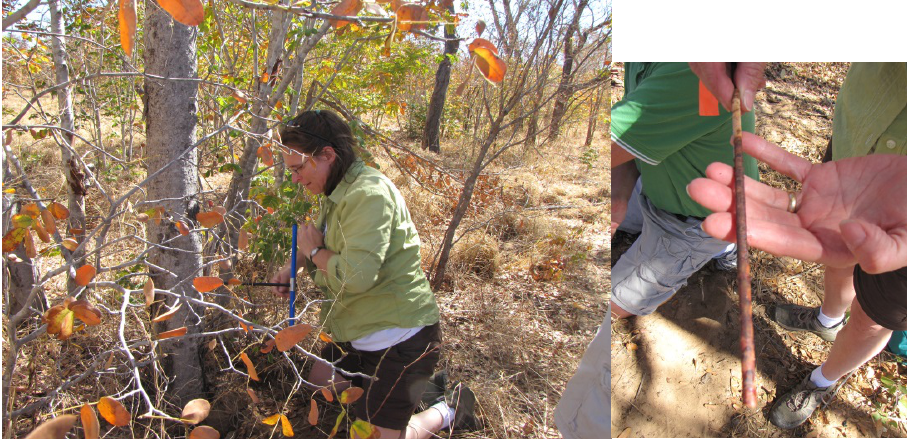
Figure 2. Field collection of tree cores by Dr. Lesley Rigg, for later lab dendrochronology analysis.